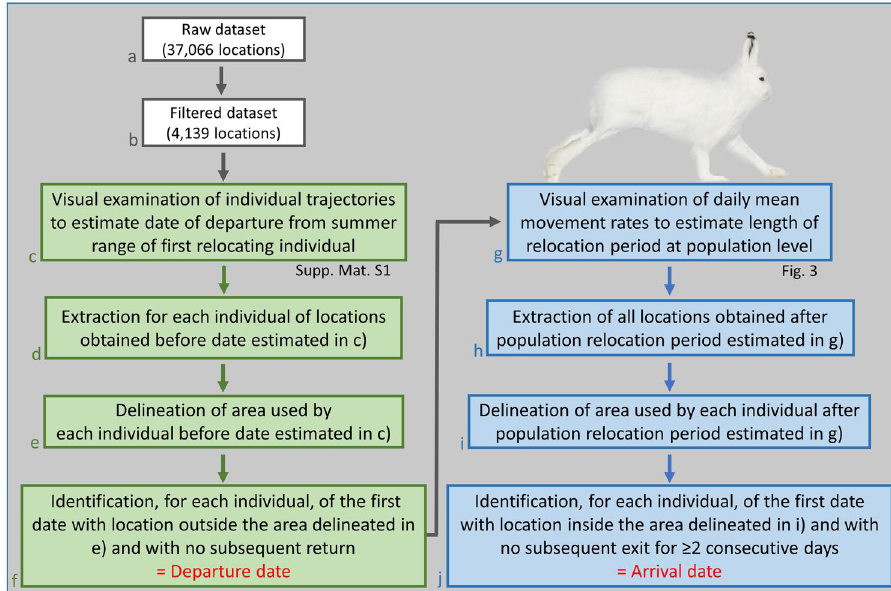
Figure 2. Methodological workflow for the identification of fall departure and arrival dates of Arctic hares tracked at Alert (Nunavut, Canada). After acquisition and filtering of location data (steps a–b, white boxes), departure dates (steps c–f, green boxes) and arrival dates (steps g–j, blue boxes) were obtained through a multi- step process involving visualization of individual trajectories and delineation of individual summer and winter grounds.